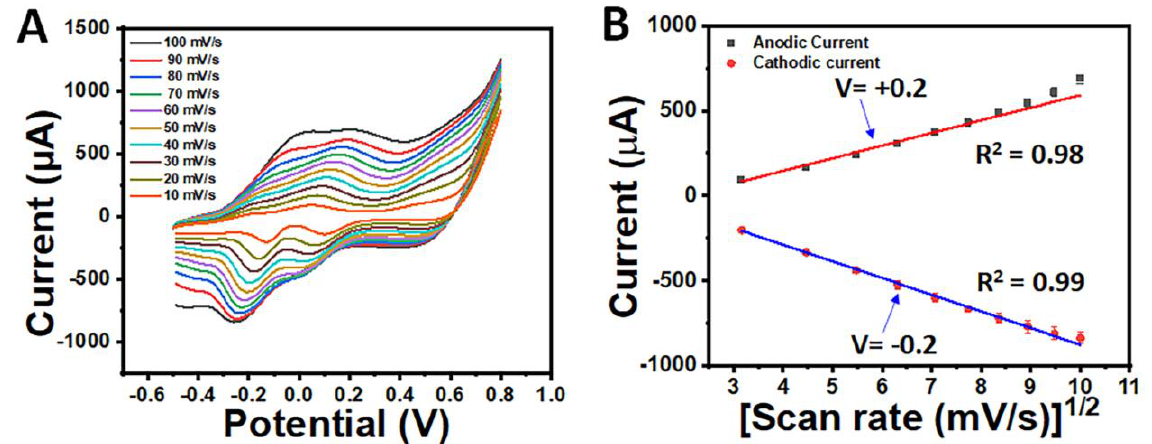
Figure 5. ( A ) Scan-rate-dependent experiment of GC/AuCoCu-imprinted surface in 0.1 M NaOH with the scan rate ranging from 10–100 mV/s; ( B ) Corresponding curve showing linearity, with a correlation coefficient of 0.98.